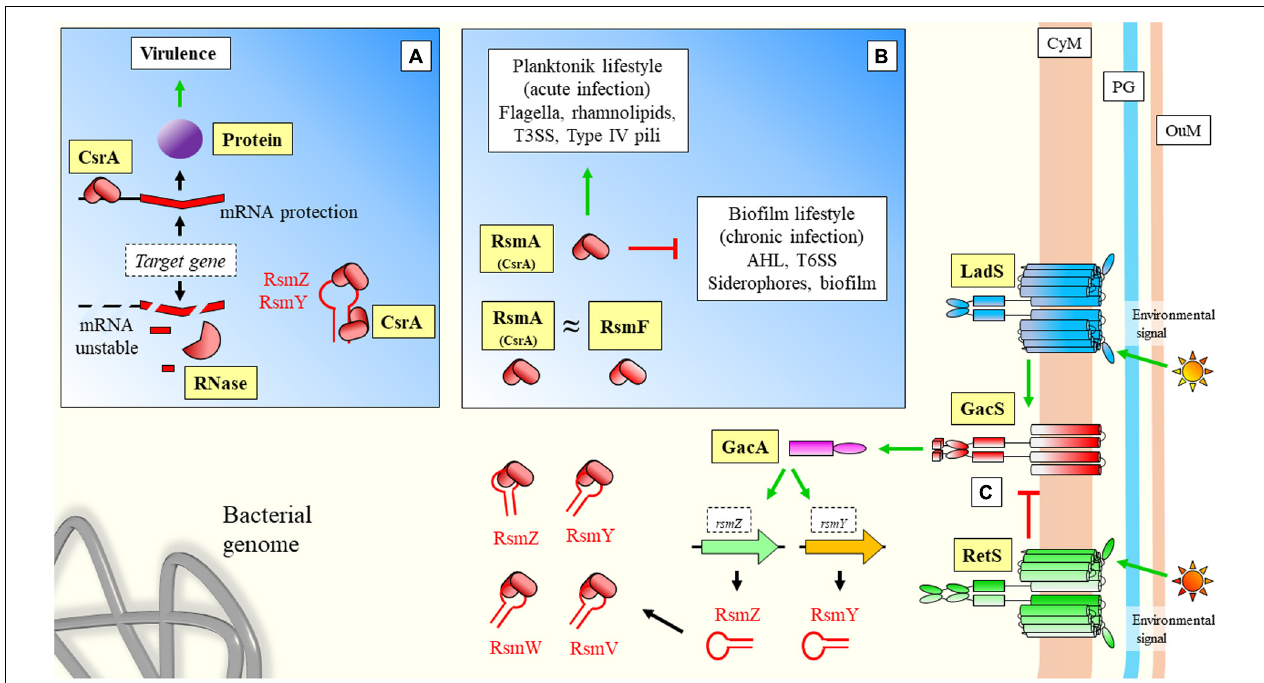
FIGURE 4 | Virulence sRNA mediated regulation in Pseudomonas aeruginosa : Role of CsrA regulatory protein and sequestration by sRNAs. (A) CsrA has been described to have also a positive effect on target mRNAs by protecting transcripts from degradation. (B) Regulatory effects of CsrA. In the case of positive CsrA regulation of targets, when sRNAs bind and sequester this protein, they force the instability and degradation of the messenger (A) . In the case of CsrA negative regulation of targets ( Figure 1A ), sRNAs can prevent binding of the regulatory protein to the mRNA allowing translation (where sRNAs have a positive effect over mRNA targets). (C) GacS/GacA two component system is either activated by LadS, or inhibited by RetS. These two transmembrane proteins mediate between GacS and environmental stimulation. Upon activaction, Gac promotes the transcription of sRNAs, which can further bind CsrA/RsmA and modify expression of downstream genes. CyM, Cytoplasmic membrane; PG, peptidoglycan; OuM, Outer membrane. Black thick arrows indicate flow of a biological process, e.g., protein translation. Green thick arrows indicate activation. Red thick arrows with flat cap indicate inhibition. Text boxes: indicate downstream effects of RsmA.